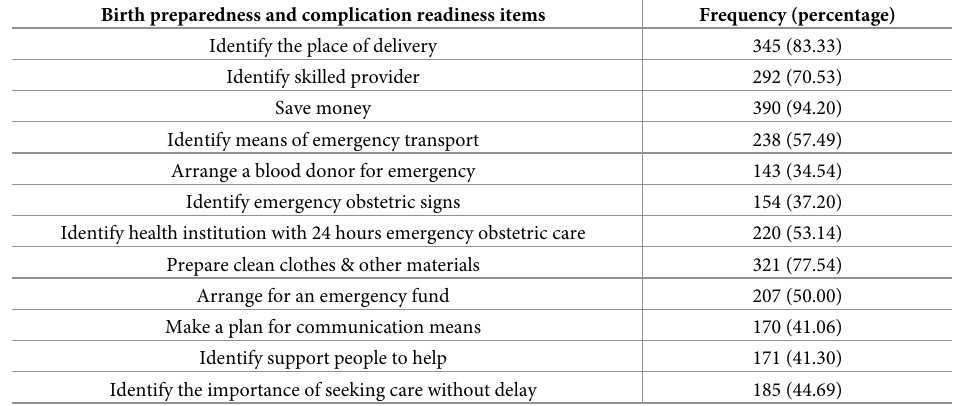
Table 2. BP/CR knowledge items among pregnant women attending antenatal care service at North Shewa zone public hospitals, Oromia region, central Ethiopia, 2021 (n = 414).